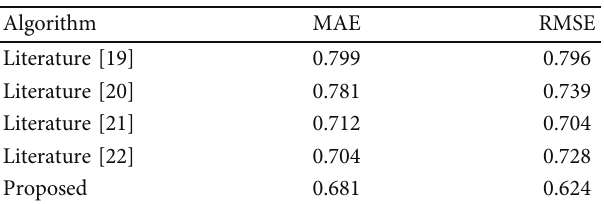
Table 4: Comparison of MAE value and RMSE value of fi ve